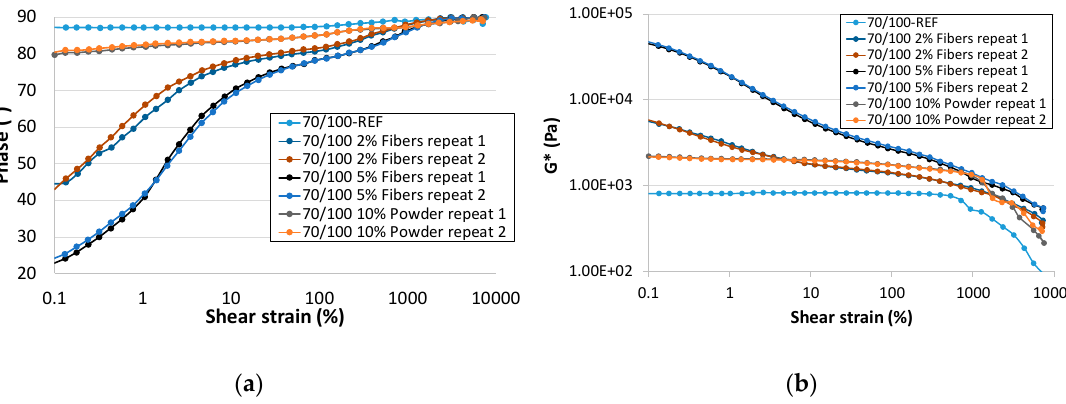
Figure 9. Stress sweeps taken at 50 °C and 0.1 Hz: ( a ) complex modulus and ( b ) phase angle.